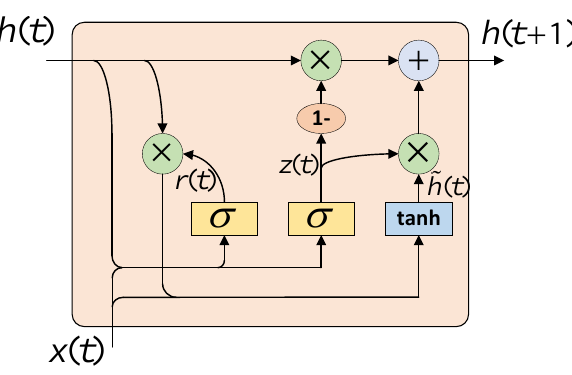
Figure 6. The structure of